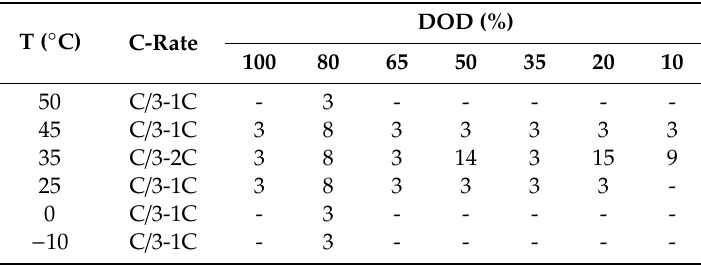
Table 1. Cycle aging test matrix, with the number of cells assigned to each test condition [32].